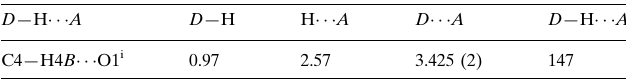
Hydrogen-bond geometry (A˚ , (cid:1)